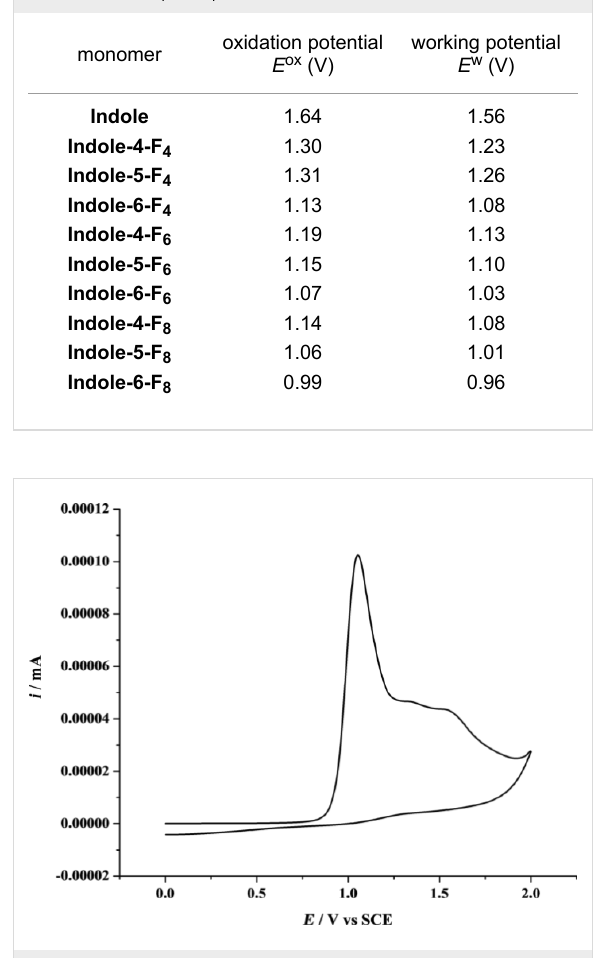
Figure 1: Cyclic voltammogram of the monomer Indole-6-F 6 (1 scan at 20 mV·s − 1 ). Electropolymerization in 0.1 M of acetonitrile/Bu 4 NClO 4